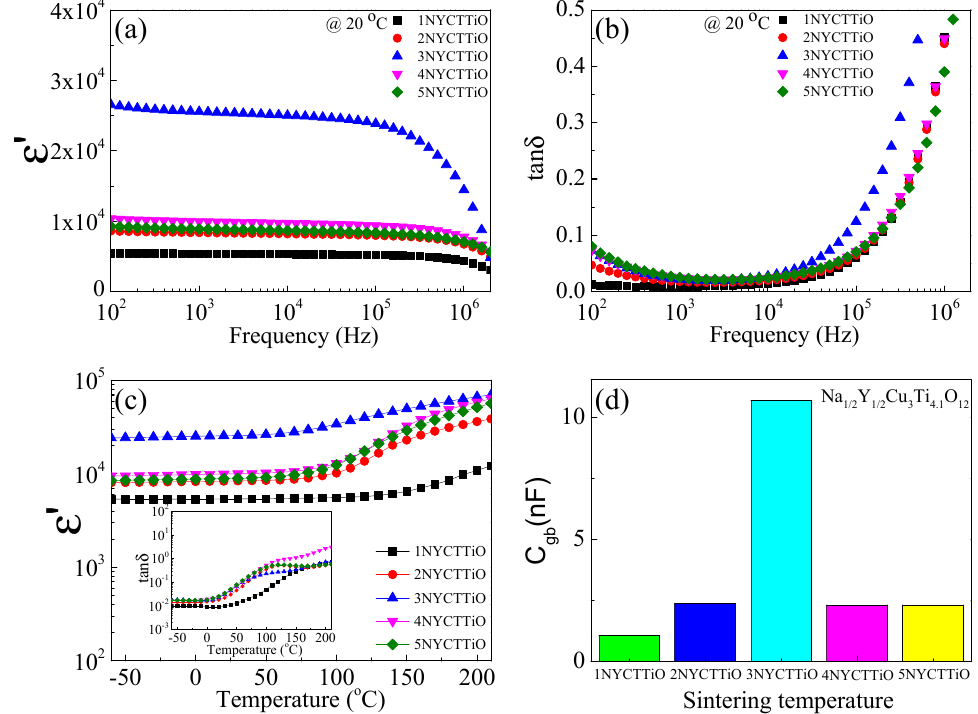
Figure 5. ( a ) Dielectric constant ( ε′ ) and ( b ) dielectric loss tangent (tan δ ) at room temperature (20 °C) as a function of frequency for Na 1/2 Y 1/2 Cu 3 Ti 4.1 O 12 ceramics sintered under different conditions. ( c ) Dielectric constant ( ε′ ) and (inset) dielectric loss tangent (tan δ ) as a function of temperature in the range of − 60 to 210 °C. ( d ) Grain-boundary capacitance (C gb ).